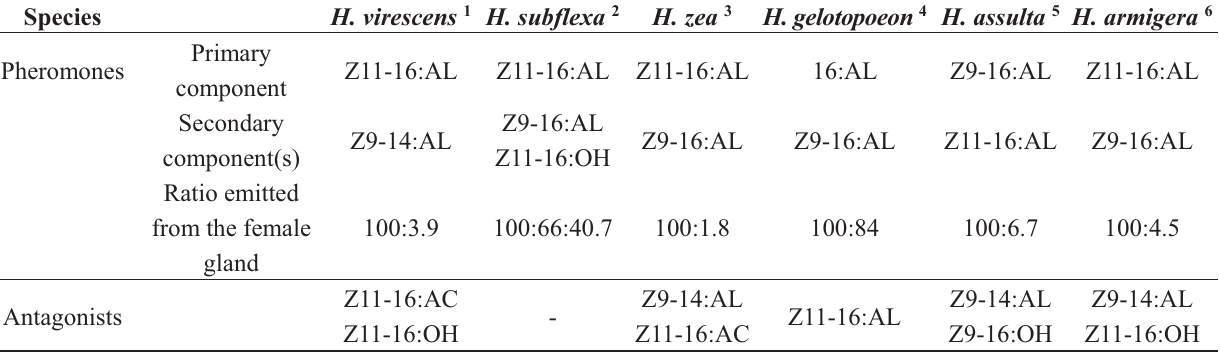
Table 1. Principal pheromone constituents and interspecific compounds detected by heliothine males.